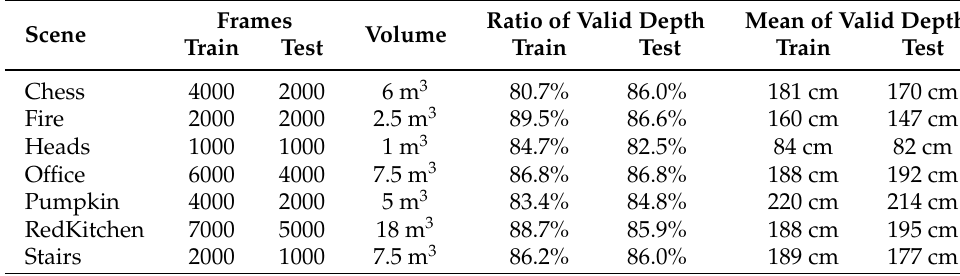
Table 1. Characteristics of 7 Scenes